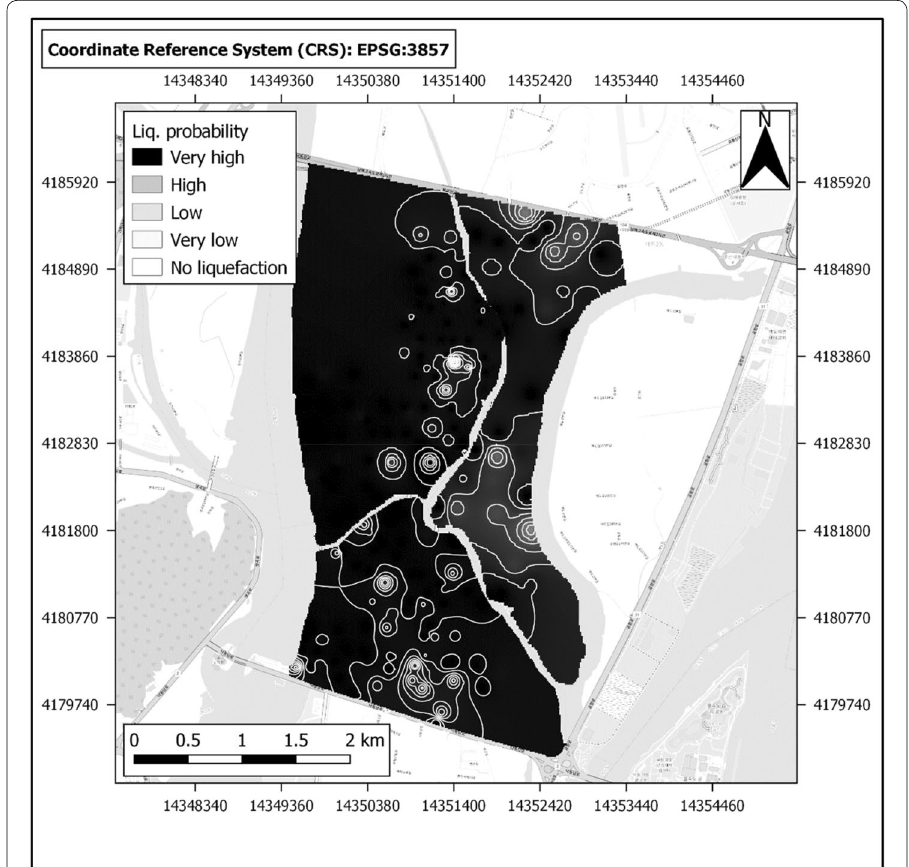
Fig. 19 Liquefaction hazard map based on OCDI [9] method for case